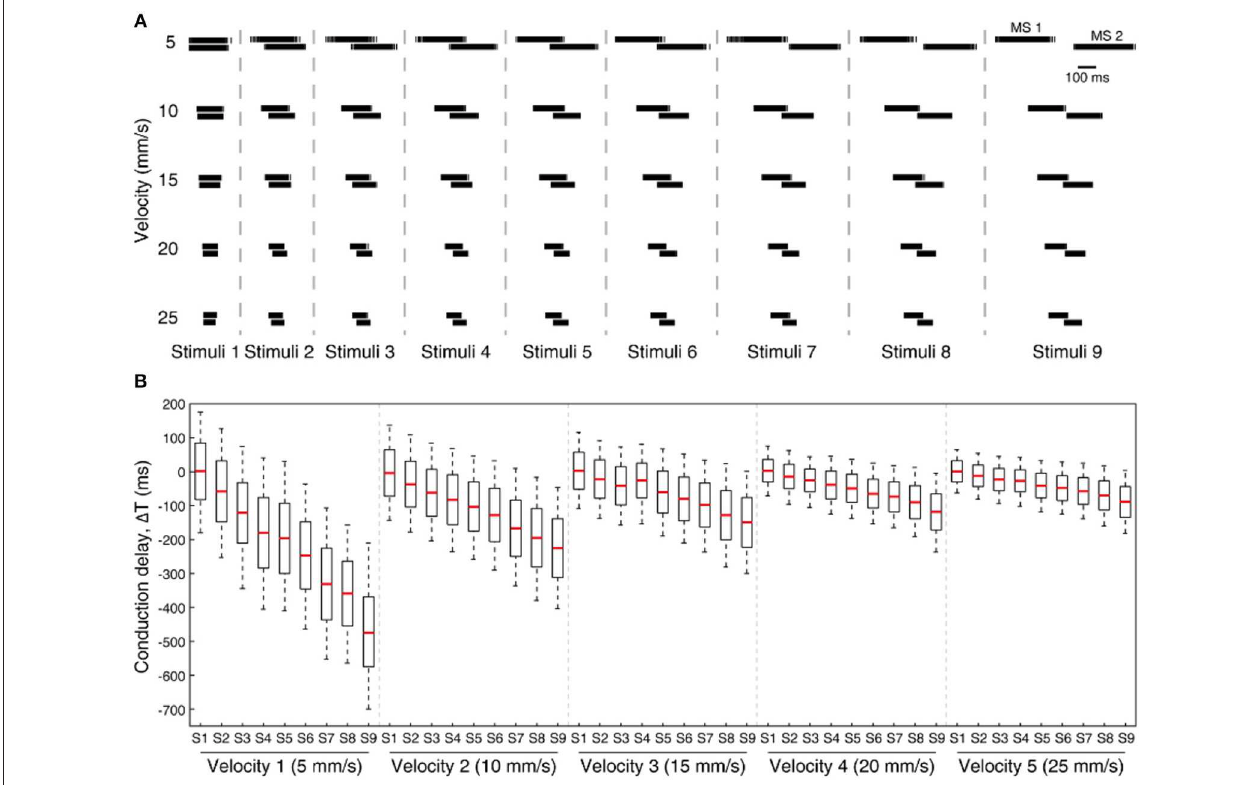
FIGURE 9 | Processing stimuli orientation across varying sensing velocity for a fixed sensing force (Z1, Figure 3C ). (A) Artificial mechanosensors (MS1 and MS2, 1st order neuron) spike train responses for all 9 stimuli, across 5 different sensing velocities. (B) Boxplot illustrates the probability of spiking across all the stimuli for 5 varying sensing velocities, for a range of conduction delays. The spiking probability is calculated on the CNs responses. Each CN model is simulated for 5 experimental repetitions with an addition of 19 noise repetitions each (gaussian distribution with σ = 10ms), constituting a total of 100 repetitions for each CN